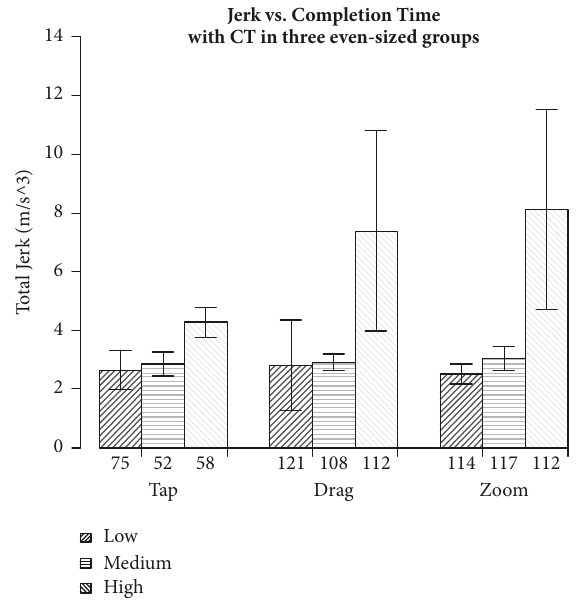
Figure 14: Jerk depending on the total task completion time (in- versed axes compared to Figure 12).